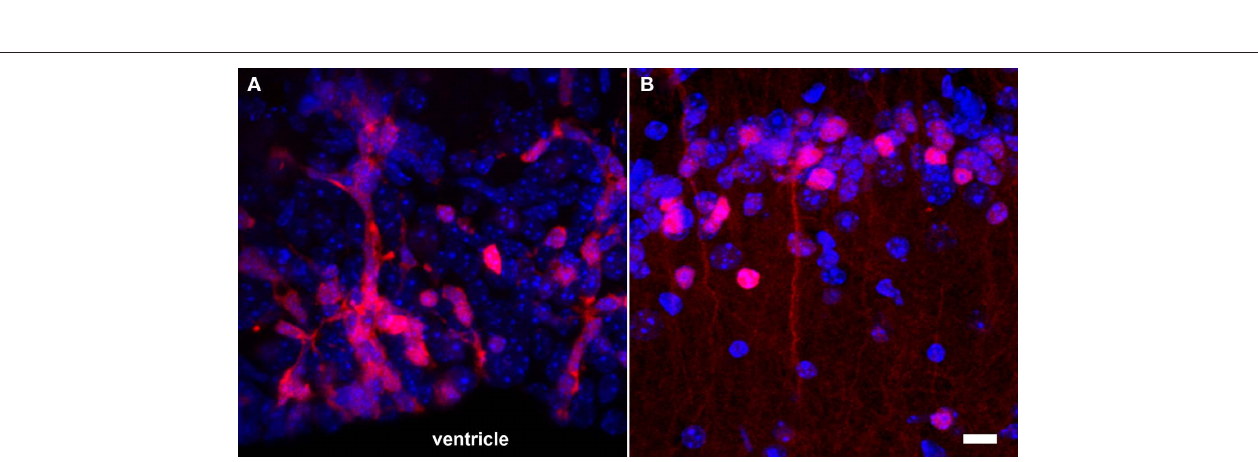
FIguRE 3 | Positron emission tomography imaging of neural stem cell proliferation ([ 18 F]-FLT–PET matched on MRI-atlas of rat brain). (A) Increased [ 18 F]-FLT signal was detected in the SVZ. (B) Location of BrdU-labeled proliferating cells in the SVZ corresponds well with the elevated [ 18 F]-FLT signal in the SVZ (A) (Adapted from Rueger et al., 2010).